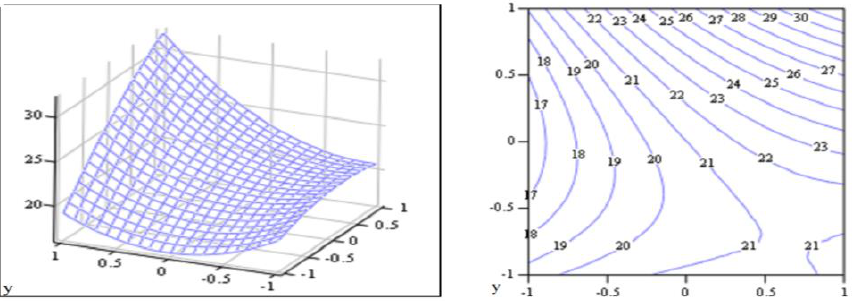
Figure 6. The graph and contour curves of the dependence of criteria Y on the factors х 1 , х 3 for cherries, when х 2 = 0.